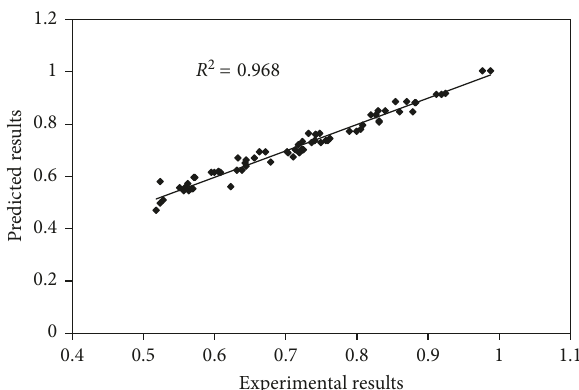
Figure 12: Linear relationship between measured and predicted flexural strengths for the Levenberg–Marquardt backpropagation algorithm of